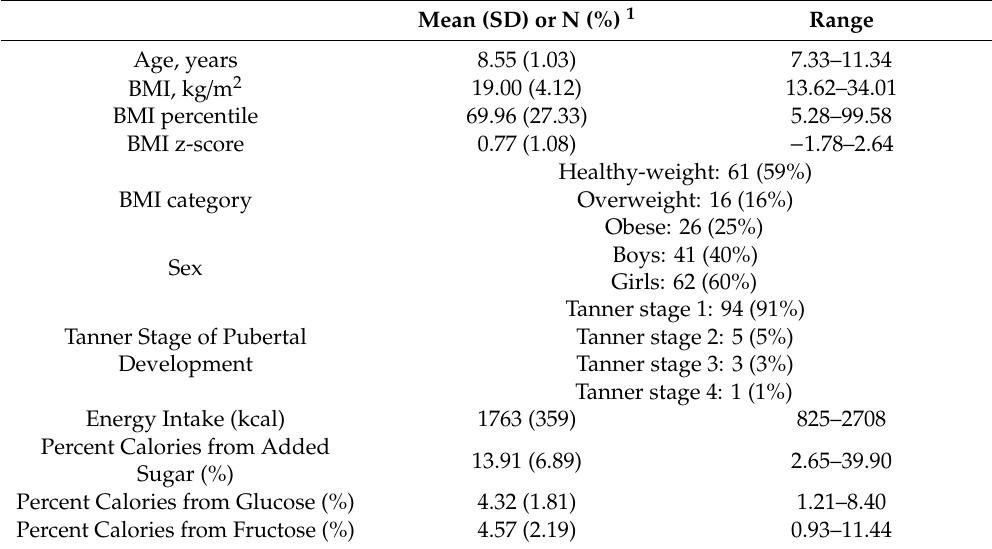
Table 1. Child demographic and clinical characteristics